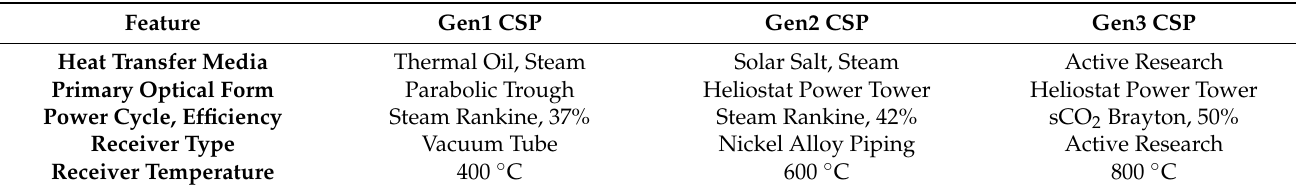
Table 1. Features of Major CSP